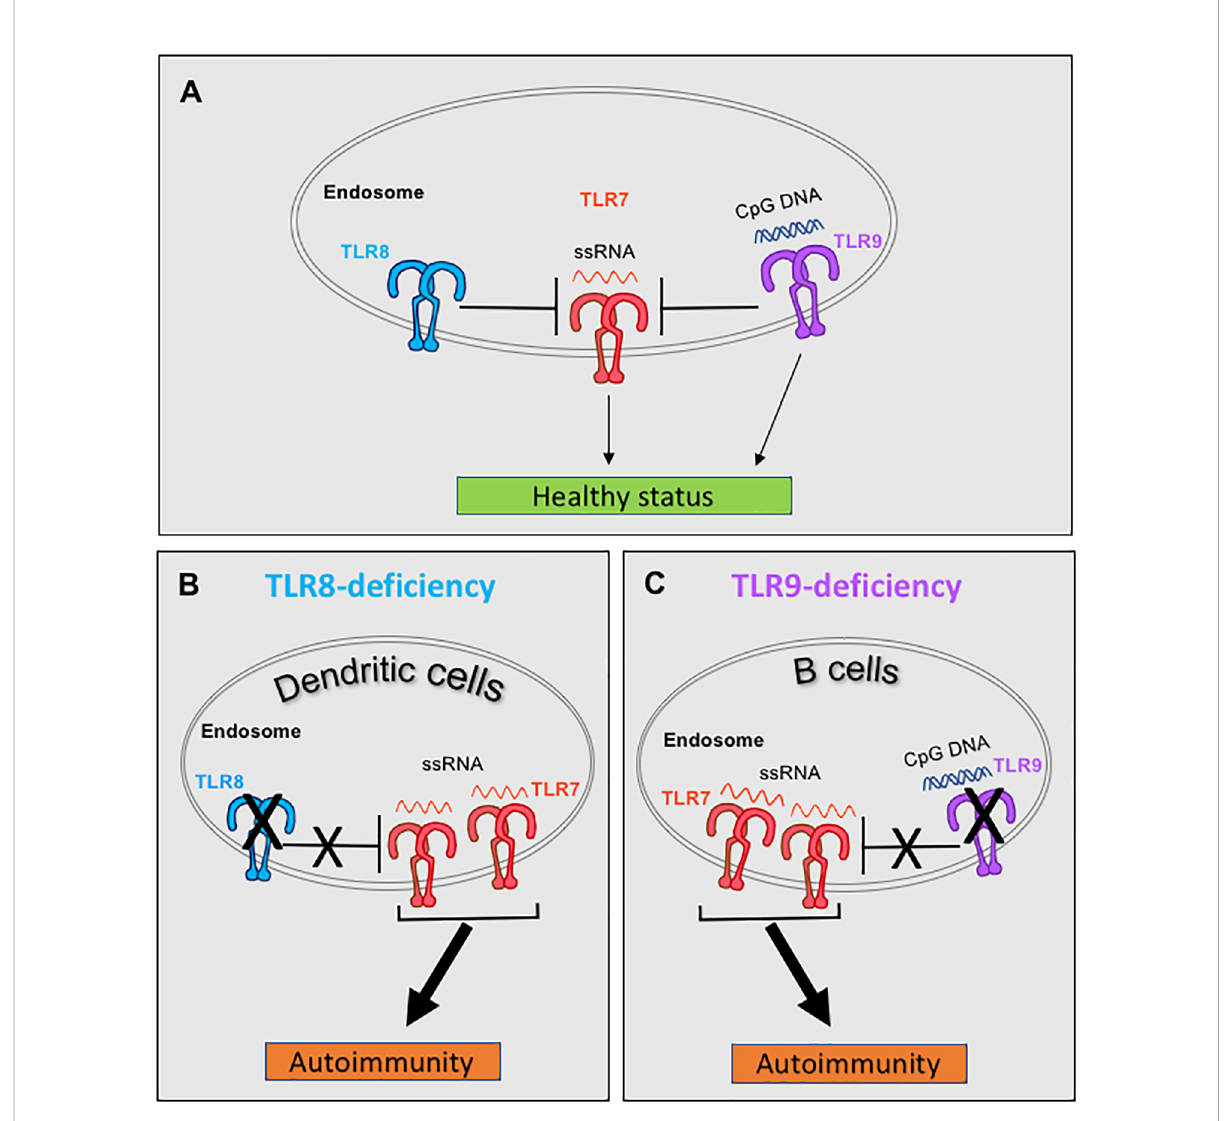
FIGURE 2 Murine TLR8 and TLR9 restrain TLR7 in dendritic cells (DCs) and B cells respectively, and protect from spontaneous autoimmunity. (A) Under normal conditions both TLR8 and TLR9 restrain TLR7 expression and signaling. (B) In C57BL/6 mice, deletion of TLR8 leads to increased expression of TLR7 in DCs, which leads to increased TLR7 signaling and development of SLE and Sjögren ’ s syndrome. (C) Deletion of TLR9 increases the number of TLR7 molecules in the endosomes (while the overall cellular TLR7 expression remains unchanged), which enables increased TLR7 signaling by B cells in TLR9-de fi cient C57BL/6 mice and the development of SLE. Discussion on similar control of TLR7 by TLR8 and TLR9 in humans are provided in the main text, in the section "Interplay of TLR7 with TLR8 and TLR9 and its importance in